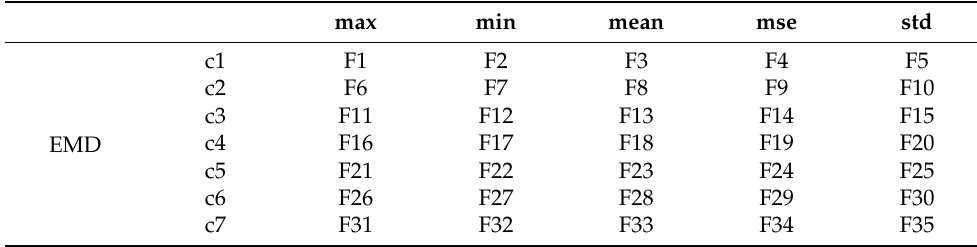
Figure 7. Instantaneous frequency of EMD. ( a ) Normal motor, ( b ) bearing fault, ( c ) interturn short circuit, ( d ) broken rotor bar. Table 2. Feature extraction of the